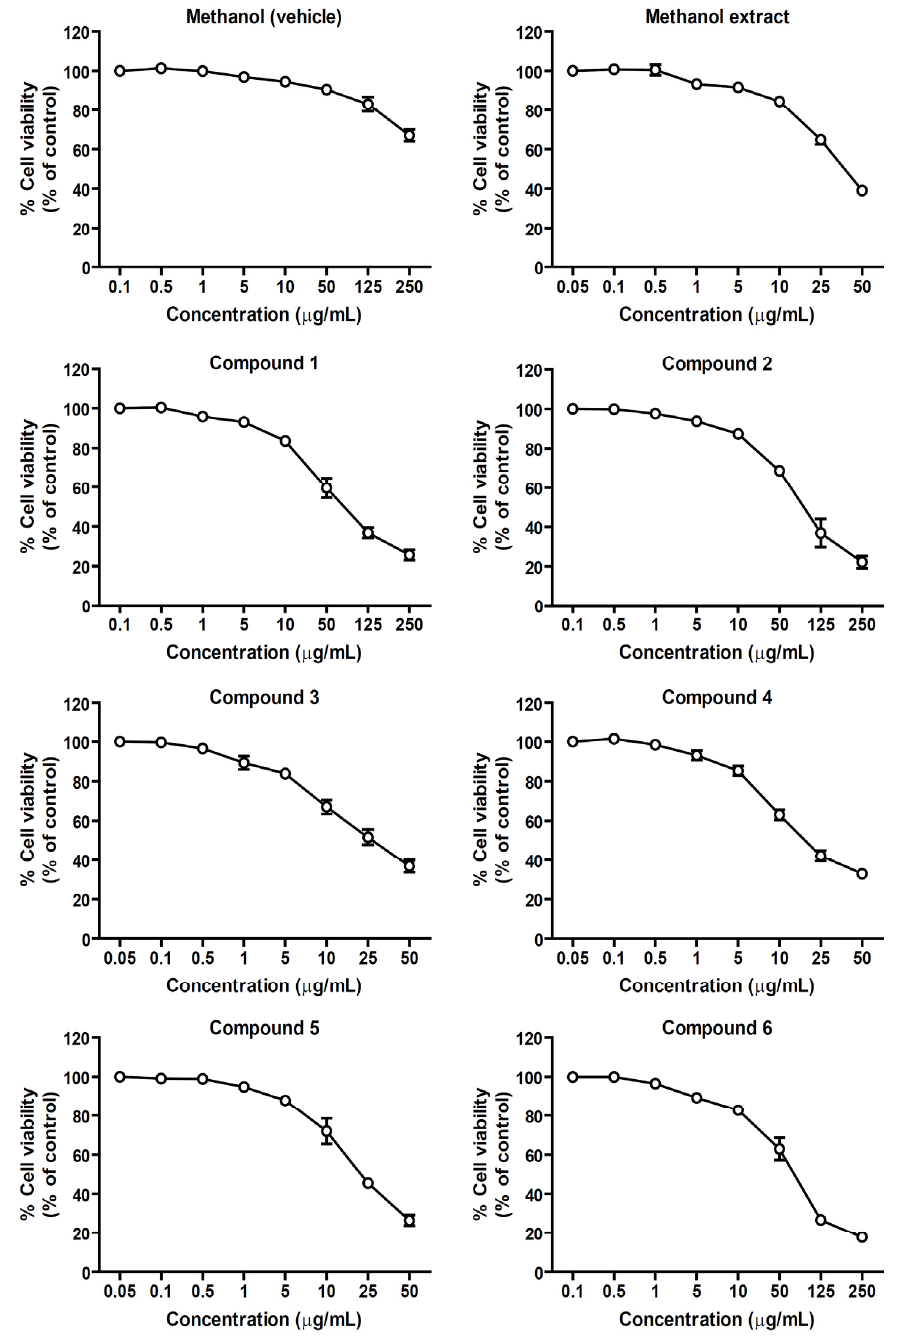
Figure 2. Cytotoxic effects of the methanol extract and isolated lignans 1 – 6 from M. sirikitiae leaves in RAW 264.7 cells; The percentage of cell viability of RAW 264.7 cells exposed to 0.05–50 µ g/mL of methanol extract and 0.1–250 µ g/mL of isolated lignans 1 – 6 . Data are shown as the mean ± SEM ( n = 5).